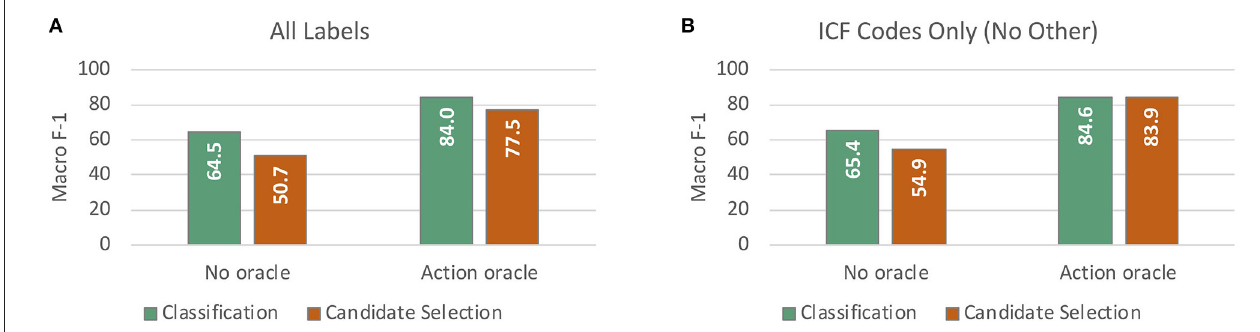
FIGURE 7 | Macro-averaged F-1 performance on test data from cross validation experiments for assigning ICF codes to mobility activity reports. (A) compares our best classification model against our best candidate selection model (with and without access to the Action oracle), taking all labels including Other into account. (B) reports the same comparison on the 12 ICF code labels only, excluding Other .